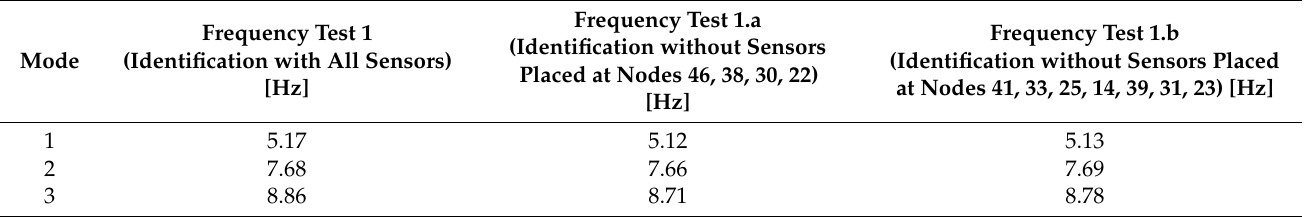
Table 3. Comparison between the identified frequency values for different set-up